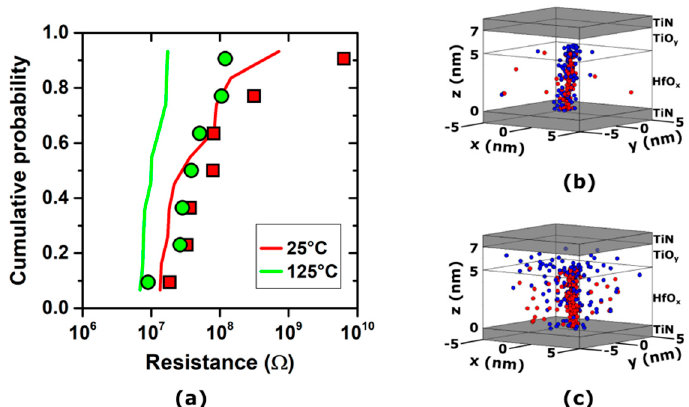
Figure 4. ( a ) Experimental (symbols) and simulated (lines) cumulative distributions of TiN/5 nm HfO x /TiO y /TiN RRAM stacks’ low state resistances after forming at 25 and 125 °C. ( b ) Resulting oxygen ions/vacancies distribution in the device after forming at 25 °C. ( c ) Resulting oxygen ions/vacancies distribution in the device after forming at 125 °C. The forming process was performed using a ramped voltage and a 1 µA compliance current.